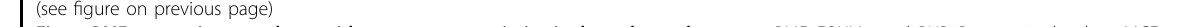
Fig. 5 BMF expression correlates with response to antimitotic drug chemotherapy. a BMF , FOXM1, and BUB1B transcript levels in MCF-7 and MDA-MB-231 cells. b BMF , FOXM1, and BUB1B transcript levels in asynchronous (untreated, unt) and mitotic (shake-off upon STLC) MDA-MB-231 cells depleted with Neg or FOXM1 siRNAs. c Individual cell fate pro fi ling of siNeg- ( n = 150) or siFOXM1-depleted ( n = 150) MCF-7 cells treated with 500 nM TX. MD mitotic duration. d Cell fate percentage of the experiments described in c . e Individual cell fate pro fi ling of siNeg- ( n = 150) or siFOXM1-depleted ( n = 150) MDA-MB-231 cells treated with 500 nM TX. MD, mitotic duration. f Cell fate percentage of the experiments described in e . g Correlation of BMF mRNA levels and paclitaxel drug sensitivity in the CTRP drug response data set. h Correlation of BMF protein levels and paclitaxel drug sensitivity in the CTRP drug response data set. i Relative BMF mRNA expression levels in tumors with complete/near-complete response vs. no response to a combination of docetaxel and capecitabine 40 . j Correlation of BUB1B mRNA levels and paclitaxel drug sensitivity in the CTRP drug response data set. k Correlation of BUB1B protein levels and paclitaxel drug sensitivity in the CTRP drug response data set. l Relative BUB1B mRNA expression levels in tumors with complete/near-complete response vs. no response to a combination of docetaxel and capecitabine 40 . Data information: In a data are mean ± S.D. from n = 3 independent experiments; * p ≤ 0.05 (two-tailed paired t test). In b data are mean ± S.D. from n = 3